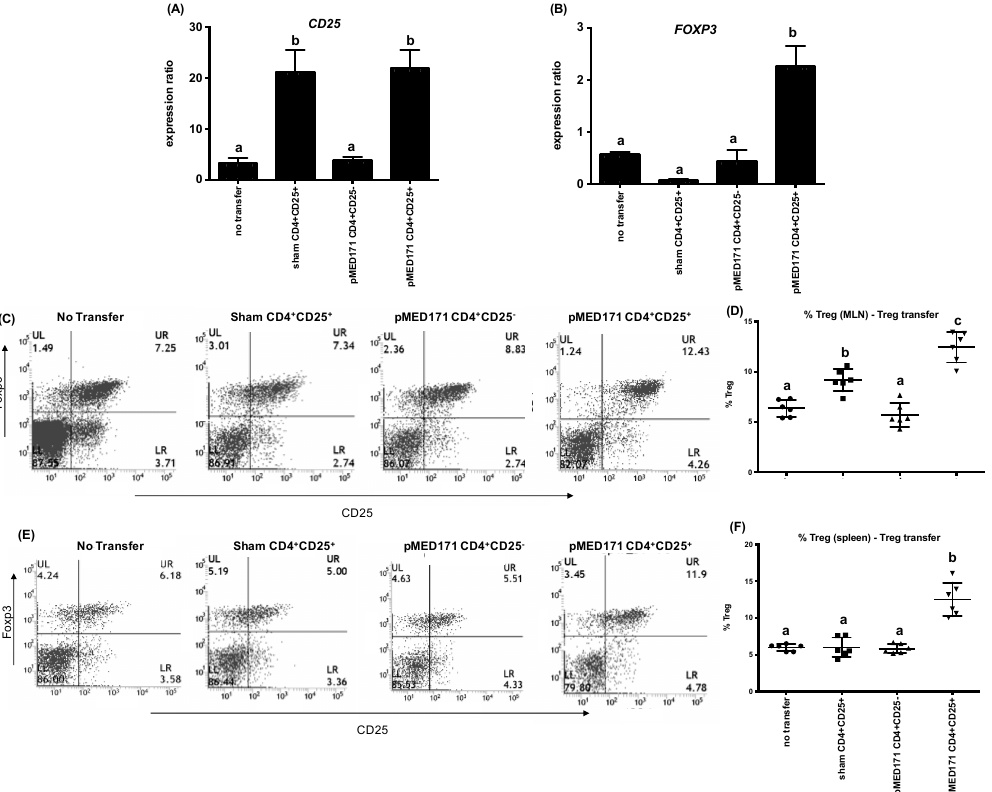
Figure 4. Treg cell responses in the recipient mice in T cell adoptive transfer experiment. Intravenous transfer of CD4 + CD25 + Treg cells led to intestinal ( A ) nonspecific upregulation of CD25 and ( B ) specific FOXP3 upregulation only in mice receiving Treg cells from a pMED171-treated donor ( C ) Representative flow plot analysis and ( D ) percentage of CD25 + Foxp3 + Treg cells gated within the CD4 + in the mesenteric lymph nodes (MLN). ( E ) Representative flow plot analysis and ( F ) percentage of CD25 + Foxp3 + Treg cells gated within the CD4 + in the spleen. Note that the peripheral transfer of Treg cells can lead to both systemic and local migration of these cells to the site of allergen exposure to o ff er protection. Data are shown as individual data points denoted by di ff erent symbols for each experimental group with mean ± SD. Statistical di ff erences among di ff erent experiment groups were determined by Bonferroni post-test after one-way ANOVA; groups denoted by the same alphabet are not significantly di ff erent, while those denoted by di ff erent alphabets are statistically di ff erent ( p <